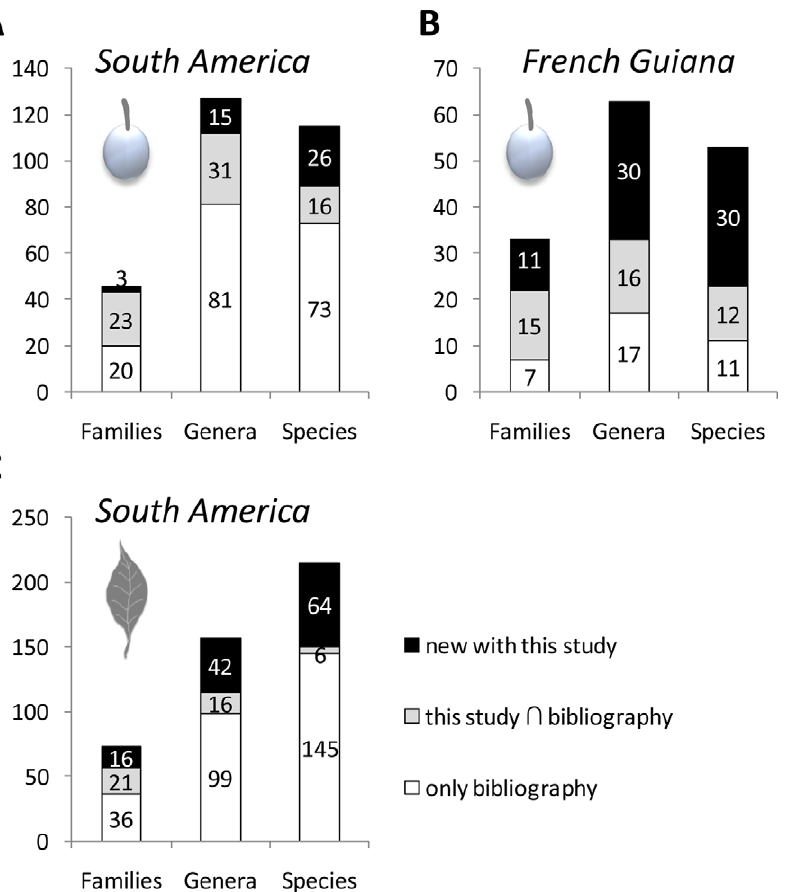
Figure 5. Numbers of identified plant taxa eaten by lowland tapirs, comparison with the bibliography. a) Comparison with the number of fruit taxa listed in South America. b) Comparison with the number of identified fruit taxa listed in French Guiana. c) Comparison with the number of identified browsed plant taxa listed in South America. Compared bibliography: Peruvian Amazon [22,25,42,43,83], North-Eastern Argentina [84], Bolivia [85], Venezuela [23], French Guiana [41] (list from their Table1), Brazil Amazon [38,39], South-Eastern Brazil [6,86-90].